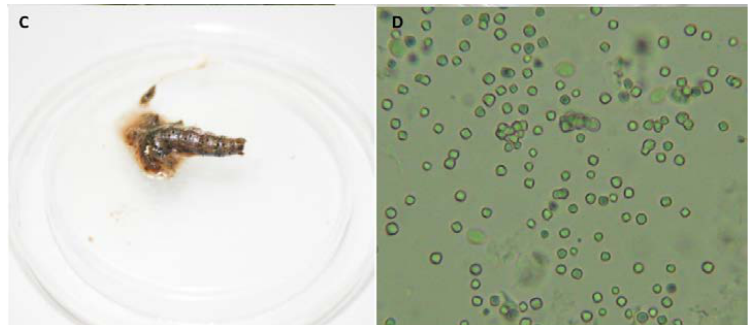
Figure 1. Larvae of S. frugiperda infected with ( A ) VG008 at 29 days post-infection, ( B ) SfCOL at 7 days post-infection, ( C ) mixture M3 after 5 days post-infection, and ( D ) nucleopolyhedrovirus occlusion bodies observed in macerates of S. frugiperda larva infected with mixture M3, examined under light microscopy (40×).